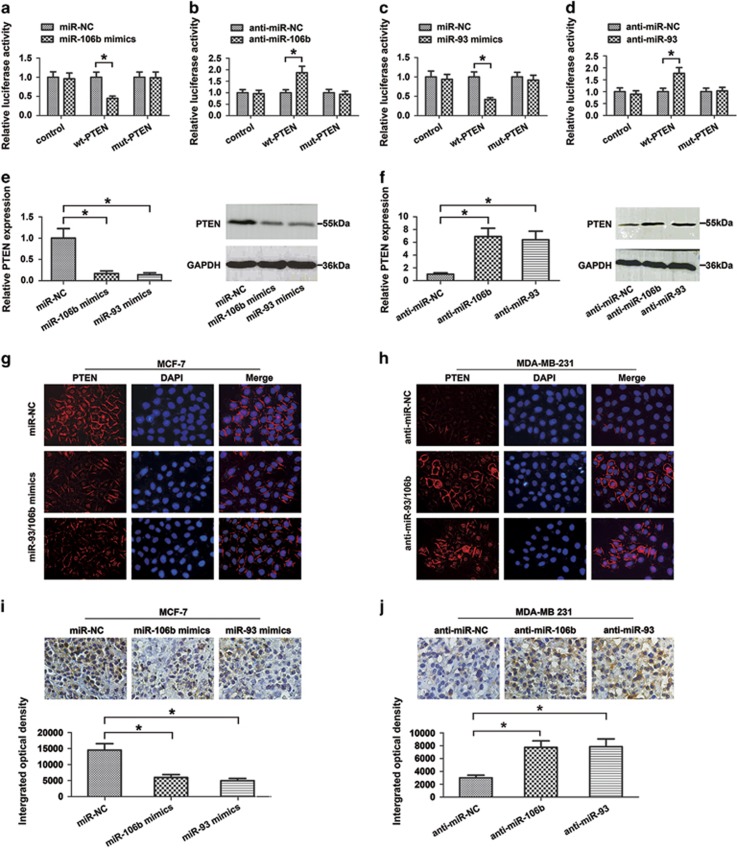
MiR-106b and miR-93 directly targeted PTEN in breast cancer. (a and c) The relative luciferase activity of MCF-7 was tested after co-transfection with Wt PTEN 3′-UTR genes and miR-106b mimics or miR-93 mimics. (b and d) The relative luciferase activity was detected after Wt PTEN 3′-UTR genes and anti-miR-106b or anti-miR-93 were co-transfected into MDA-MB-231 cells. (e and f) qRT-PCR and western blot assays showed the altering expression of PTEN after transfection with miRNA mimics (miR-NC, miR-106b mimics and miR-93 mimics) or anti-miRNA (anti-miR-NC, anti-miR-106b and anti-miR-93) (g) PTEN level was reduced in MCF-7 cells transfected with miR-106b mimics or miR-93 mimics according to the IF assay. (h) Higher expression level of PTEN was presented in MDA-MB-231 cells treated with anti-miR-106b or anti-miR-93. (i and j) The expression of PTEN in tumor tissues was examined by IHC assay. Each experiment was independently performed at least three times. Data were presented as mean±S.D. (*P<0.05)